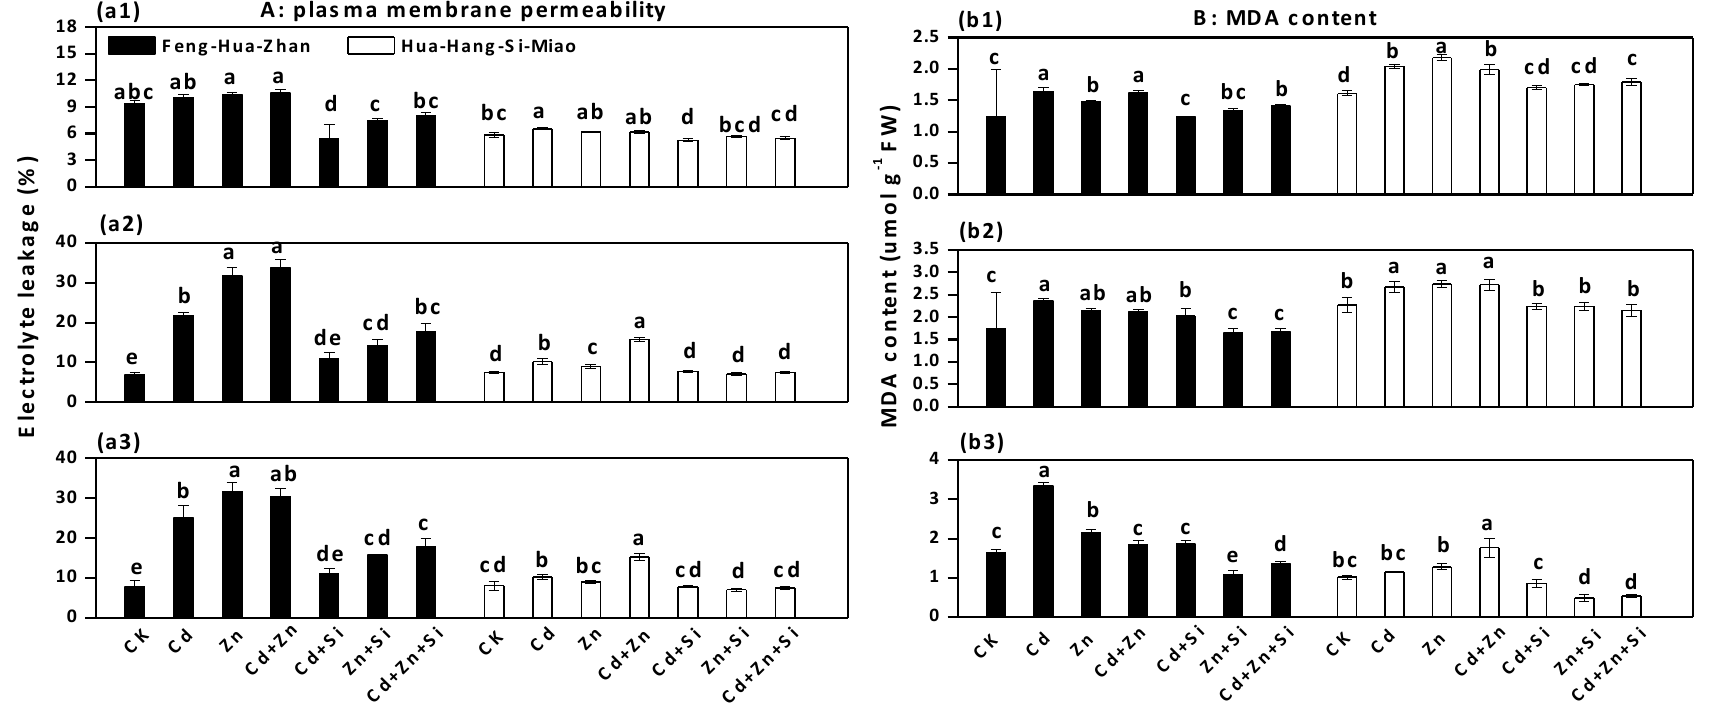
Figure+4. "Effect"of"Si"on"plasma"membrane"permeability"and"MDA"content"in"two"rice"cultivars"at"different"growth"stages:"( a1 )"and"( b1 )"seedling"stage;"( a2 )"and"( b2 )"tillering"stage;" Figure 4. Effect of Si on plasma membrane permeability and MDA content in two rice cultivars at different growth stages: ( a1 ) and ( b1 ) seedling stage; ( a2 ) and ( b2 ) ( a3 )"and"( b3 )"ripening"stage."Error"bars"indicate"standard"deviations"( n "="4)."Bars"with"different"letters"are"significantly"different"( p% <"0.05)"according"to"Duncan’s"MRT." tillering stage; ( a3 ) and ( b3 ) ripening stage. Error bars indicate standard deviations ( n = 4). Bars with different letters are significantly different ( p < 0.05) according to Duncan’s